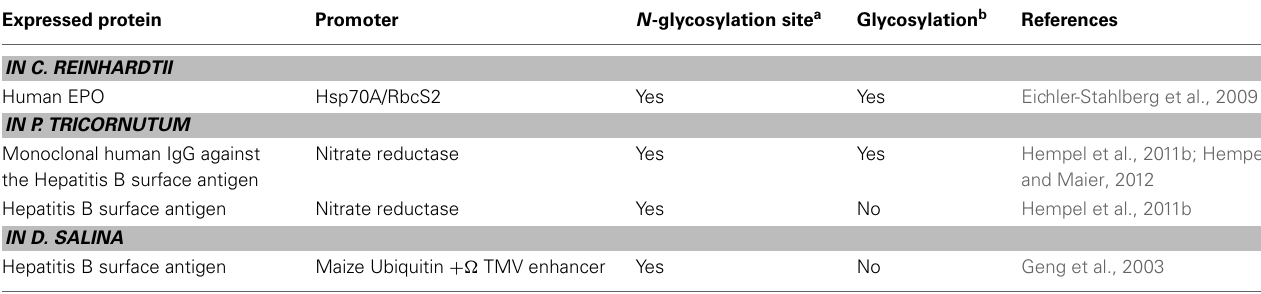
Table 1 | Post-translational modifications of biopharmaceuticals expressed in the secretory system of microalgae. Expressed